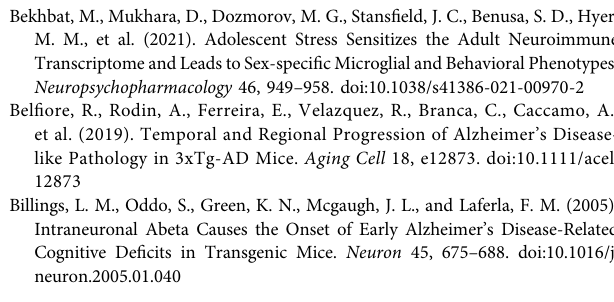
Supplementary Figure S1 | Effect of AIE on female cortex AD pathology and gene expression. (A) RT-PCR for human APP transgene expression in adult female cortex showed no differences between control and AIE-treated 3x-Tg- AD mice ( p = 0.69, N = 7 control, N = 7 AIE). (B) Western blot (WB) found no effect of AIE on A β 1 – 42 protein levels in adult female cortex ( p = 0.72, N = 7 control, N = 6 AIE). (C) RT-PCR for human MAPT transgene expression in adult female cortex showed no differences between control and AIE-treated 3x-Tg- AD mice ( p = 0.99, N = 7 control, N = 7 AIE). (D) Adult cortex proin fl ammatory gene expression in control and AIE-treated 3xTg-AD mice. AIE persistently increased proin fl ammatory gene expression of MCP-1, TNF α , and TLR4 in the female cortex. (2-way ANOVA with Sidak ’ s post-test and FDR p-value correction, *q < 0.05, ** q < 0.01, male: N = 6 control, N = 7 AIE; female: N = 7 control, N = 8 AIE). (E) Adult female cortex in fl ammatory gene expression showed no signi fi cant change in microglial gene expression due to AIE. Mann- Whitney t - tests with FDR correction, N = 7 control, N = 8 AIE. (F) RT-PCR for the human tau transgene ( MAPT ) found no effect of AIE on MAPT gene expression in female hippocampus ( p = 0.062, N = 6 control, N = 7 AIE). Supplementary Figure S2 | AI E effect on male Alzheimer ’ s pathology and gene expression. (A) RT-PCR for human APP transgene expression in adult male hippocampus (P200) showed no differences between control and AIE-treated 3x-Tg-AD mice ( p = 0.56). (B, C) Western blot (WB) found no effect of AIE on A β 1 – 42 protein levels in adult (B) hippocampus ( p = 0.31) or (C) cortex ( p = 0.79). (E) RT-PCR for human APP transgene expression in adult male cortex (P200) showed no differences between control and AIE-treated 3x-Tg-AD mice ( p = 0.96). Representative images for A β 1 – 42 immunohistochemistry (IHC) in male entorhinal cortex (ENT), arrows highlight stained cell bodies. Quanti fi cation of IHC for A β 1 – 42 showed no change in male entorhinal cortex (ENT Cx) ( p = 0.59, N = 3 control, N = 4 AIE). (F) RT-PCR for human MAPT transgene expression in adult male hippocampus (P200) showed no differences between control and AIE-treated 3x-Tg-AD mice ( p = 0.27). (G, H) WB found no effect of AIE on p-tau-181 levels in adult male (G) hippocampus (p = 0.64) or (H) cortex ( p = 0.69). N = 6 control, N = 8AIE. Supplementary Figure S3 | Effects of AIE on other behavioral tests. (A) No differences in time spent snif fi ng during NORT training were found across groups. (B) Reversal learning. AIE had no effect on acquisition of reversal learning in the MWM. (C) Reversal learning retention in the probe trial. Crosses over the reversal target region showed trends for a reduction in Mino and AIE groups, that reached statistical signi fi cance in the AIE + Mino group. (D) Prepulse inhibition. No differences in PPI were seen across groups. (E) Piezo sleep testing. No differences in sleep time during dark and light phases were found across groups. N = 5 control, N = 5 control + Mino, N = 9 AIE, N = 8 AIE +